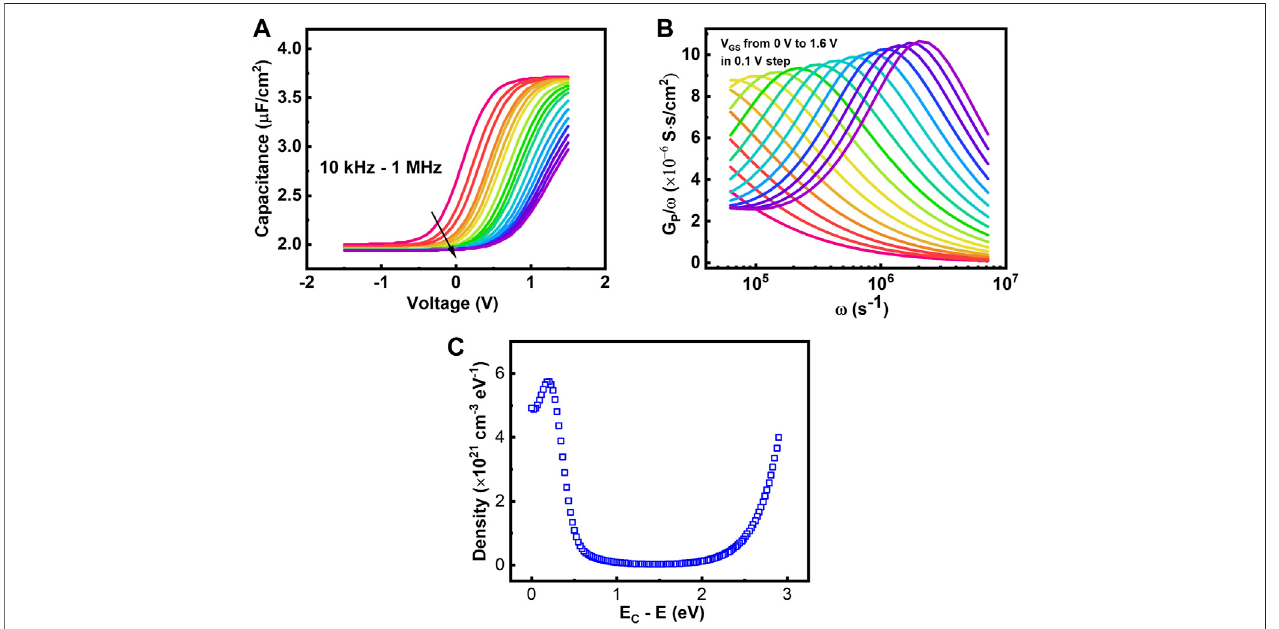
FIGURE 6 | Simulated (A) C – V and (B) G P / ω - ω characteristics of the gate stack, considering the impact of bulk traps. (C) Bulk trap state distribution used in the